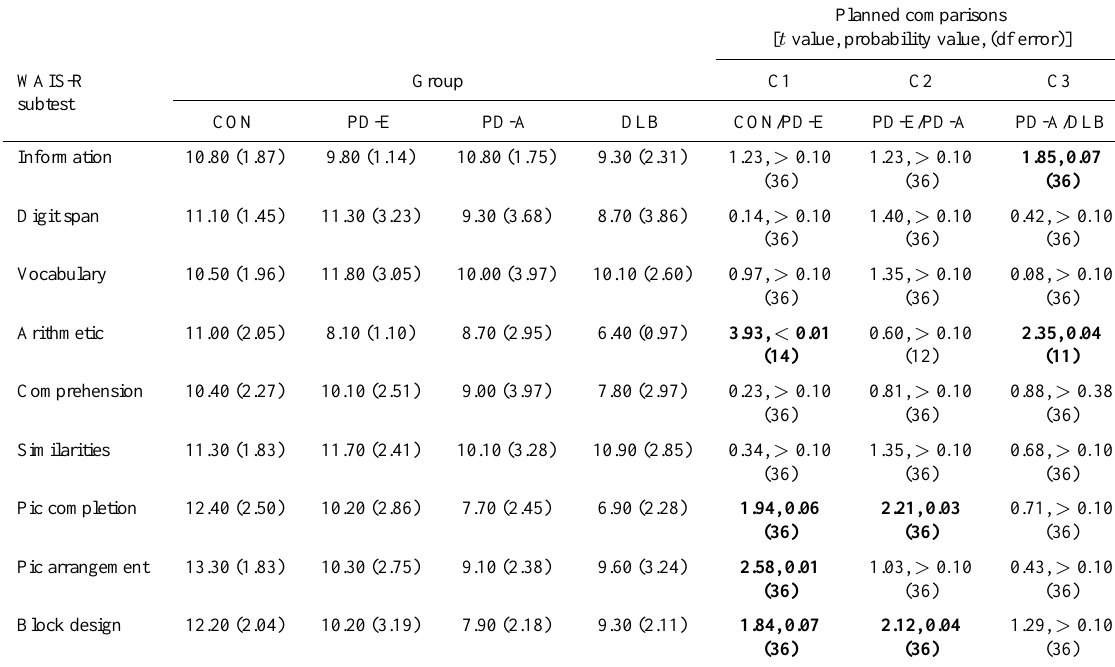
Table 3 Means, standard deviations and planned comparisons for WAIS-R subtests Planned comparisons [ t value, probability value, (df